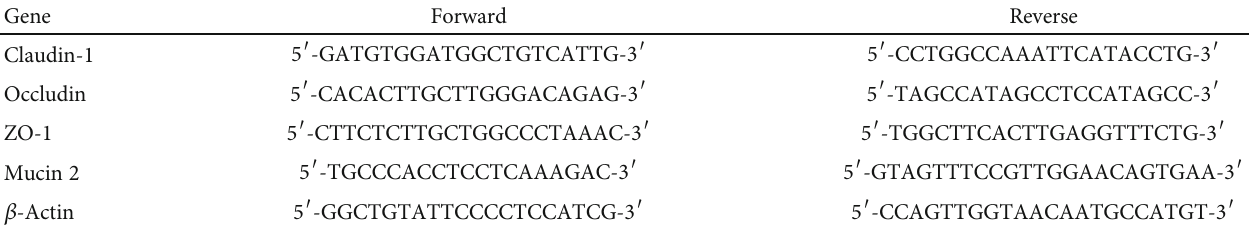
Table 1: Primers sequences used for